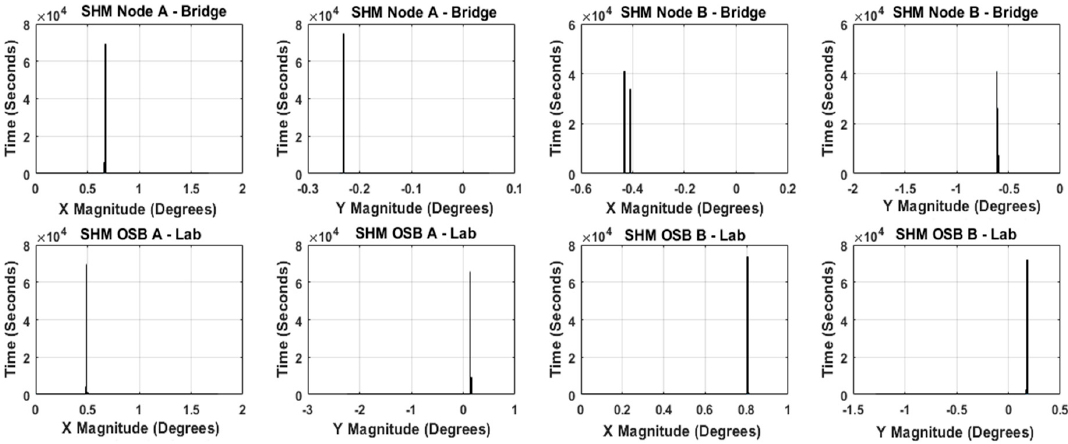
Figure 18. Histogram of data gathered at 2 unique geolocations in 5 calendar months (80,000 samples).